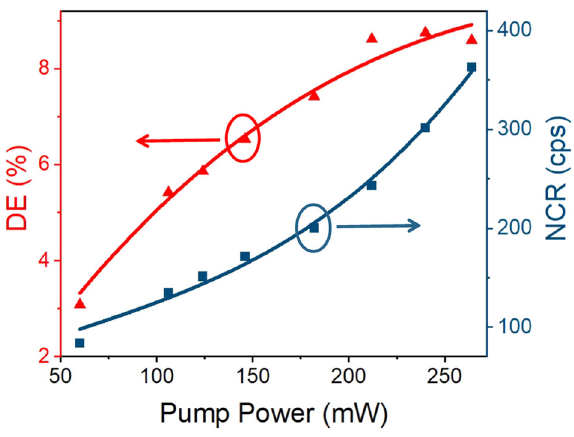
Fig. 6 DE and NCR of the upconversion SPD. The plot shows the dependence of the DE (red line, triangle) and NCR (blue line, square) on the pump power.